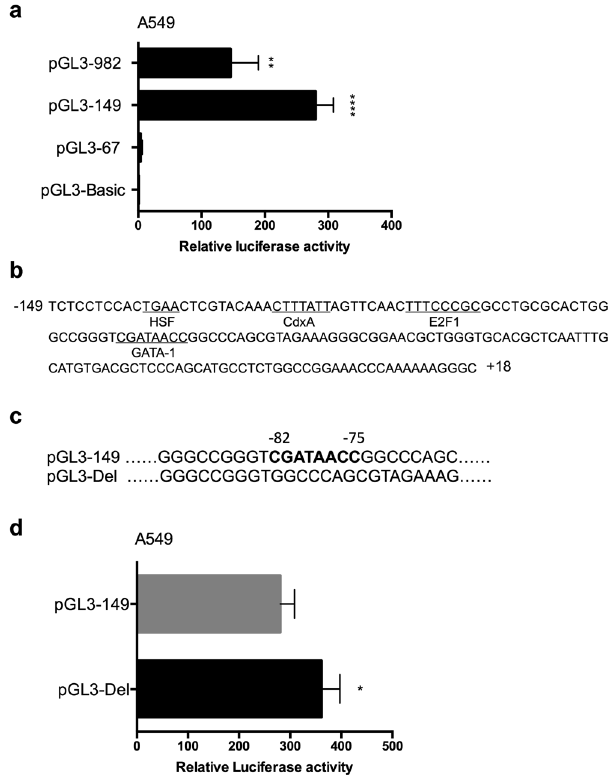
Figure 1. Functional analysis of putative GATA-1 element in IRF-3 promoter. ( a ) Relative luciferase activities of truncated plasmids of IRF-3 promoter. ( b ) Putative consensus binding sites of transcription factors were identified by TFSEARCH ver.1.3 and Matlnspector. ( c ) Nucleotide sequences of the original and GATA-1 element deleted version of pGL3-149 plasmid (pGL3-Del). ( d ) The promoter activity of pGL3-149 and pGL3- Del in A549 cells. Error bars represent the mean ± S.D. (n = 3). Statistical analyses were done using Student’s-t tests. * p < 0.05; ** p < 0.01; **** p < 0.0001 compared with